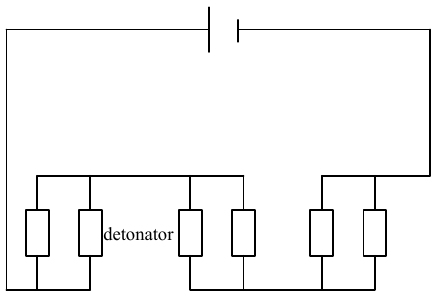
Figure 5. Parallel-series connection of electric firing network.